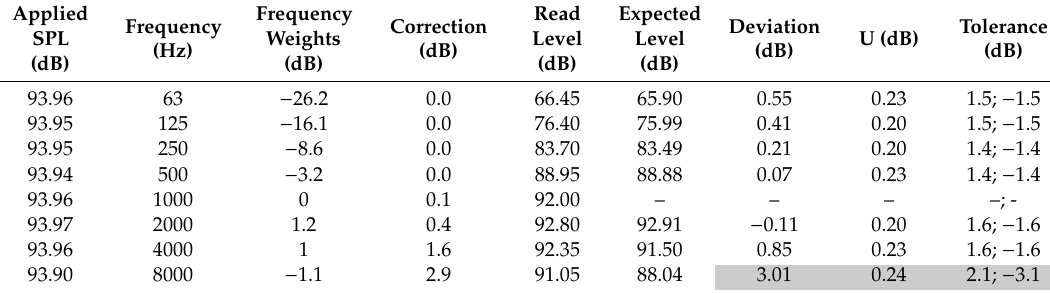
Table 5. The obtained results. At 8000 Hz, we can see that the microphone response deviation falls outside the positive tolerance for a type I instrument (marked in